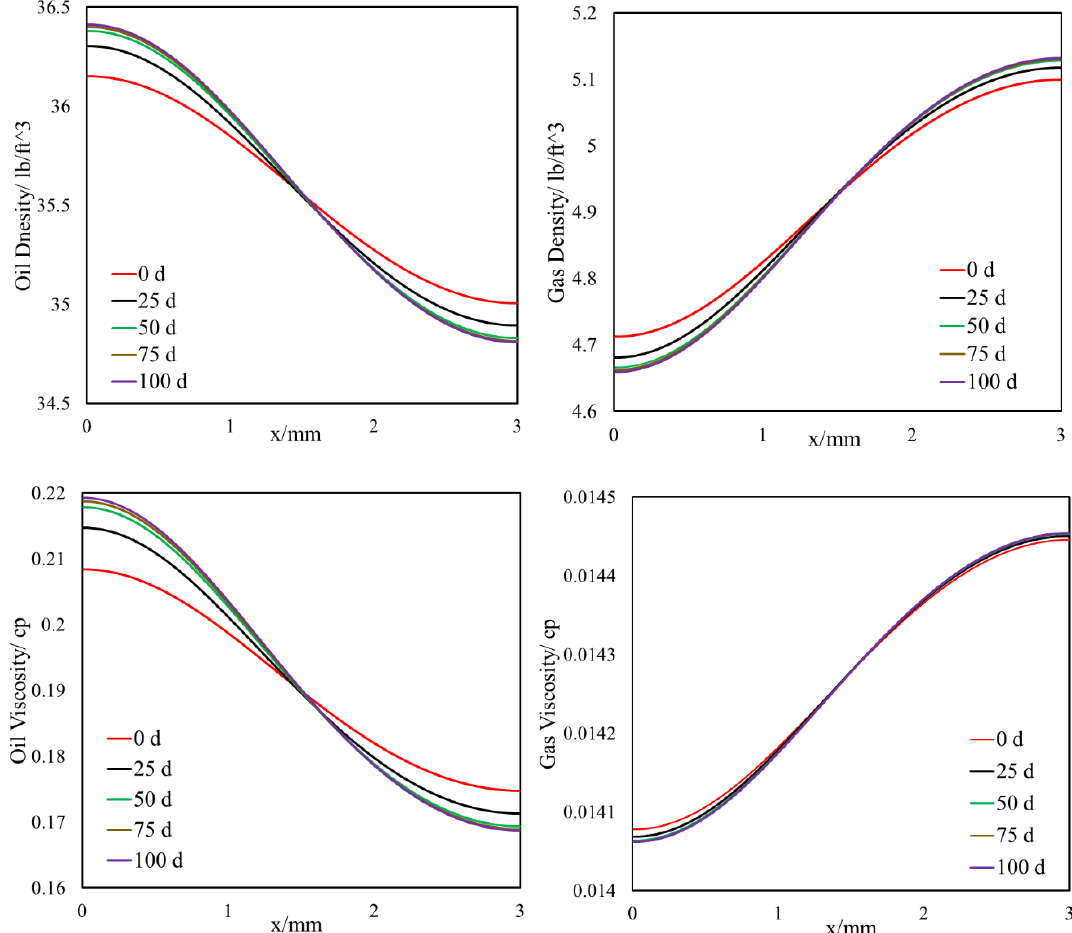
Figure 7. Oil and gas density / viscosity profile at di ff erent positions and di ff erent di ff usion times, ternary mixture.